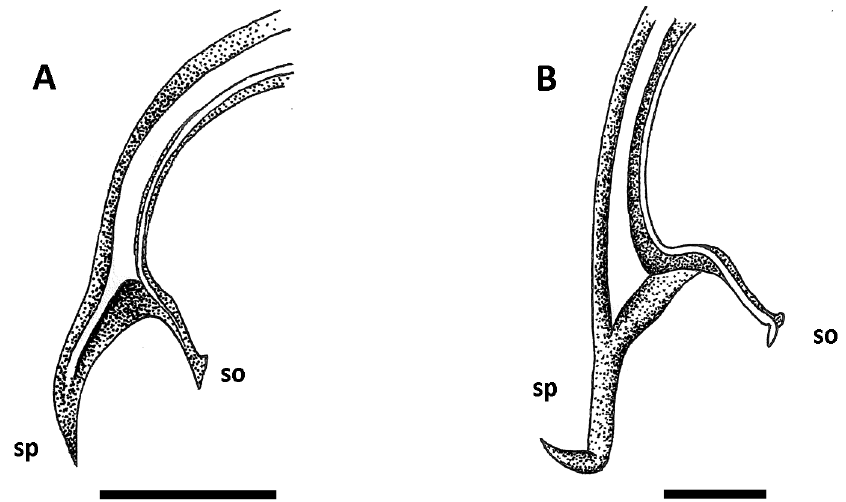
Fig. 15. Emphysemastix spp., gonopod tip. A . E. dracarys Olsen & Enghoff sp. nov., holotype, ♂ (NHMD 621675). B . E. frampt Olsen & Enghoff sp. nov., holotype, ♂ (NHMD 621677). Abbreviations: so = solenomere; sp = subterminal process. Scale bars: 0.25